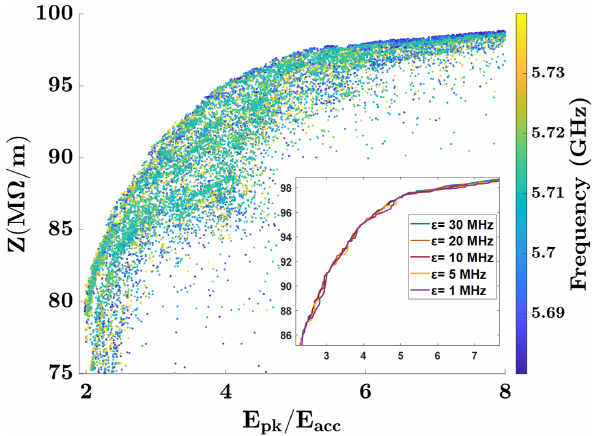
FIG. 7. Frequency handling investigation results, showing all optimization points and the variation in the Z vs E fronts for different values of ϵ (the feasible difference from the ideal frequency).